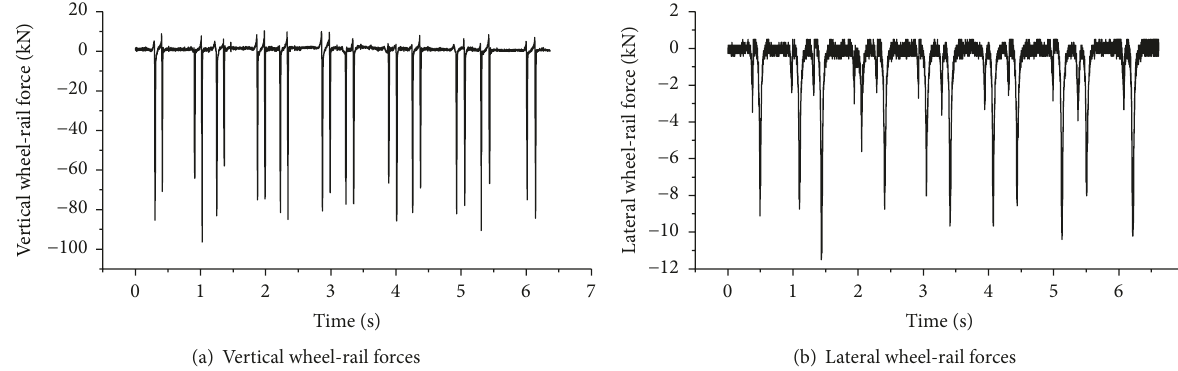
Figure 7: Time-history curves of wheel-rail forces for straight common ballastless